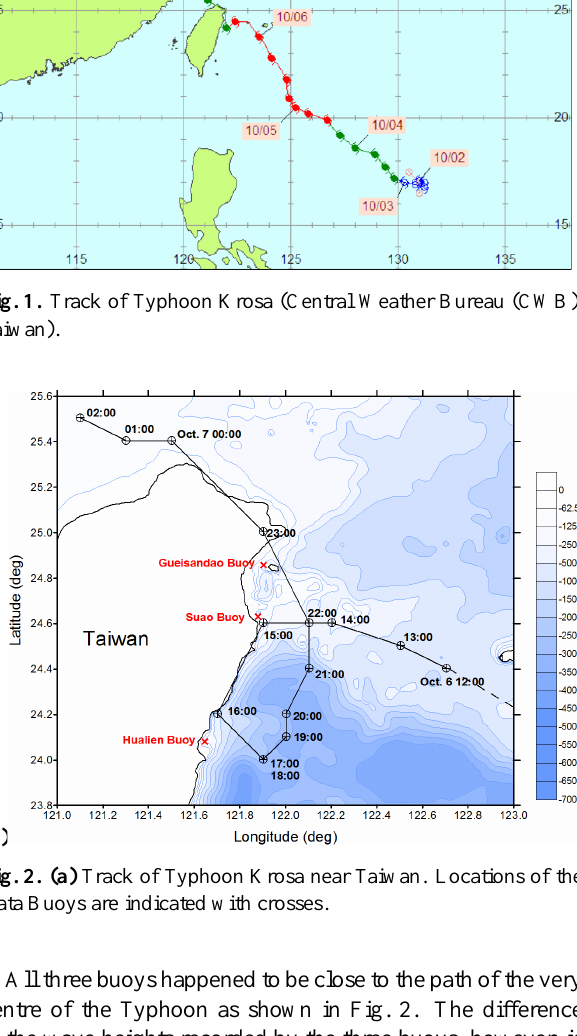
Fig. 2. (a) Track of Typhoon Krosa near Taiwan. Locations of the Fig. 2. (top) Track of Typhoon Krosa near Taiwan. Locations of the Data Buoys are indicated with Data Buoys are indicated with crosses. crosses.